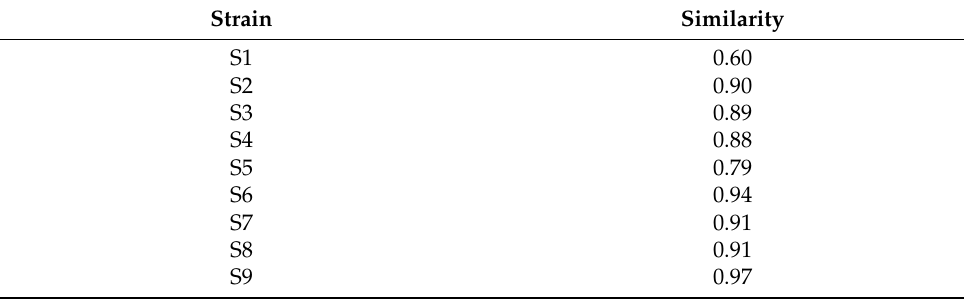
Figure 7. HPLC fingerprint analysis of SHFs from strains S1–S9. Table 5. Component similarities of SHFs from the nine strains under SSF.